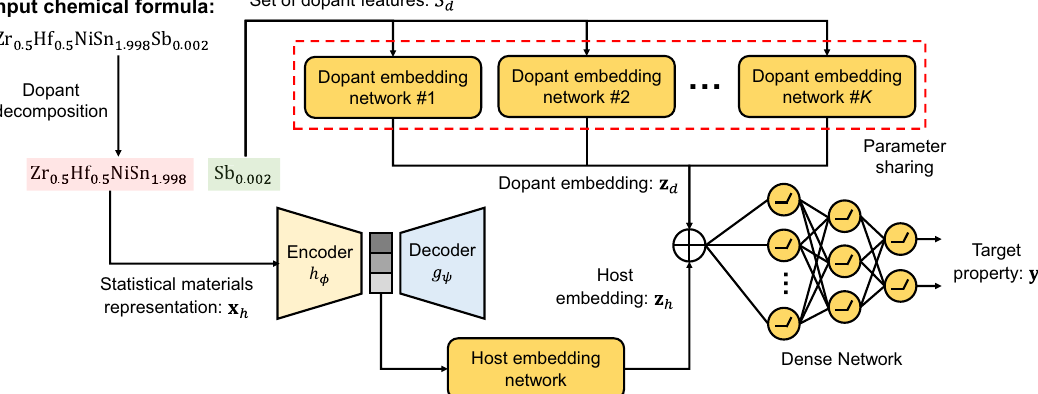
Fig. 2 Architecture of DopNet and its forward process to predict target materials property y from the chemical formula